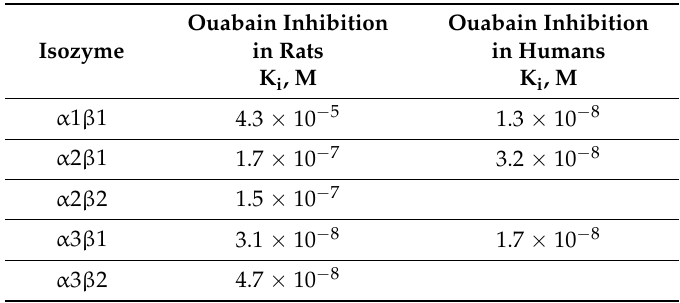
Table 1. Inhibition constant (K i ) of the Na-K-ATPase isozymes [22,23]. Ouabain Isozyme